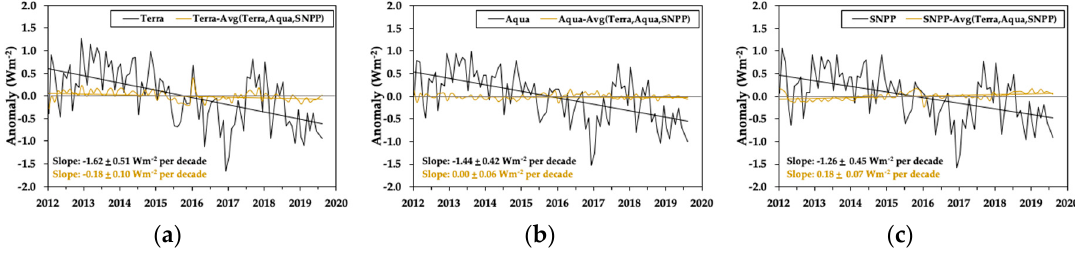
Figure 1. SW global all-sky flux anomalies for the period 02/2012–09/2019 using the SSF-1deg products for: ( a ) Terra using the Edition-4 data products; ( b ) Aqua using the Edition-4 data products; and ( c ) S-NPP using the Edition-1 data products. Additionally, shown is the difference between the individual instrument anomalies and the anomaly of the average of the three instruments. Uncertainties in slope correspond to 95% confidence intervals.